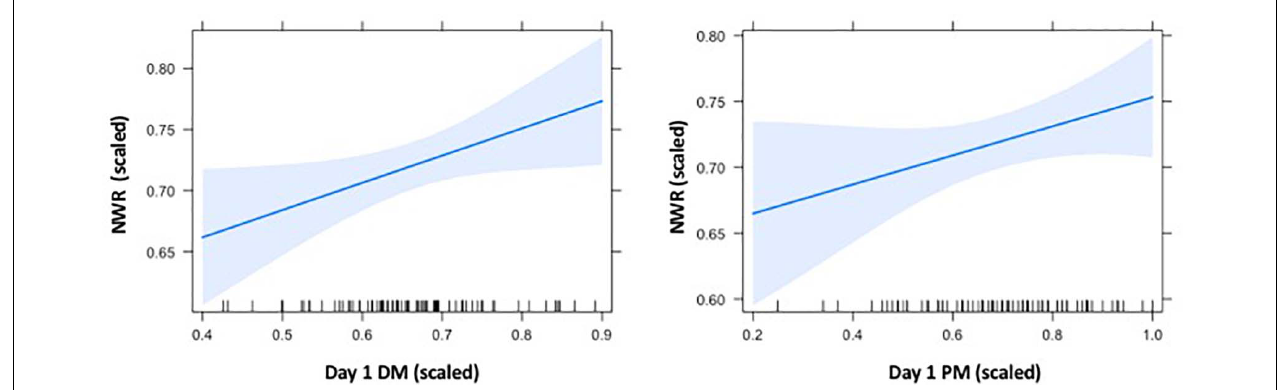
FIGURE 2 | Effect plots for Session 1 memory abilities on nonword repetition (NWR). Figure depicts the relative predictive relationships between NWR and DM assessed shortly after learning, and NWR and PM, and controlled for site. Values for all variables are scaled according to the proximity-to-maximum method (Moeller, 2015). As in Figure 1 , graphs were generated using the package “effects” in R (Fox et al., 2016), and shaded regions represent the pointwise confidence band for the predictor